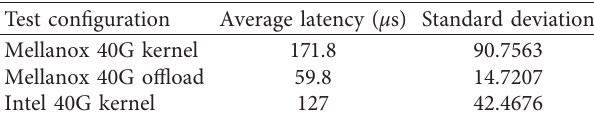
with seven parameters. (a) 5 MHz bandwidth. (b) 10MHz bandwidth. 0 Table 9: System 3: latency results per NIC configuration. Sampling